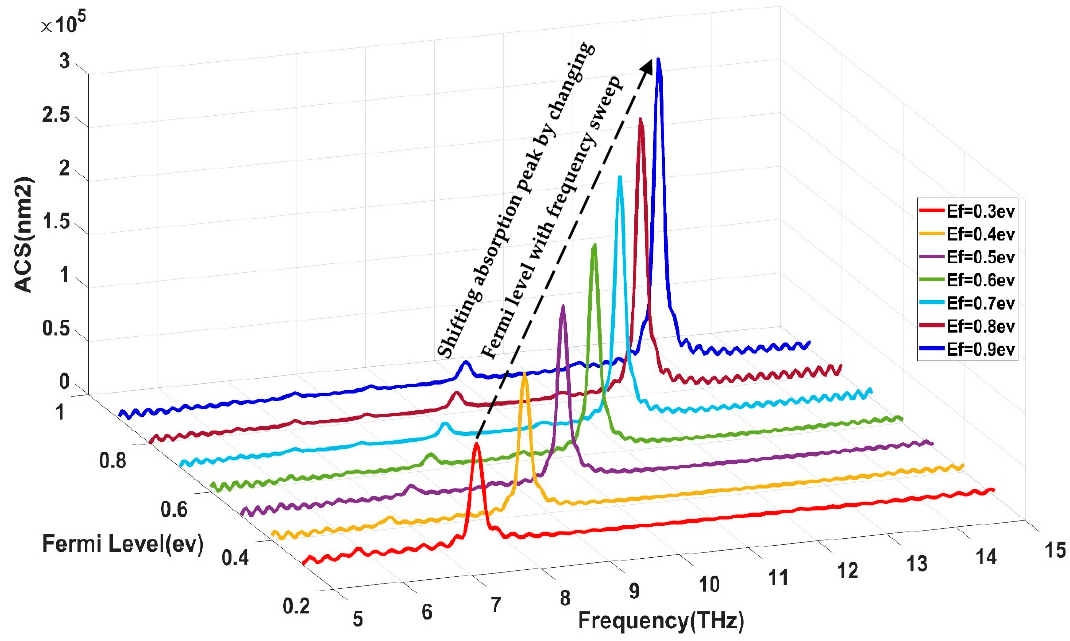
Figure 7. Spectral sweep of the modeled perfect absorber by Fermi level changing.